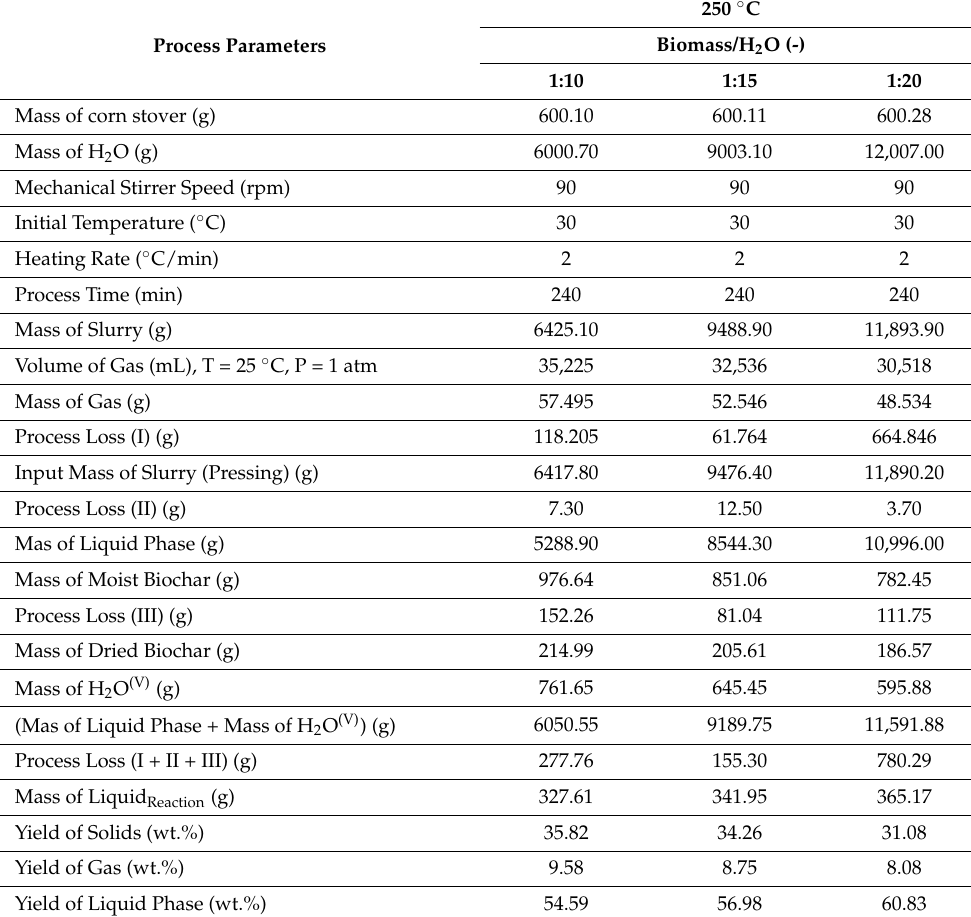
Mass of Moist Biochar